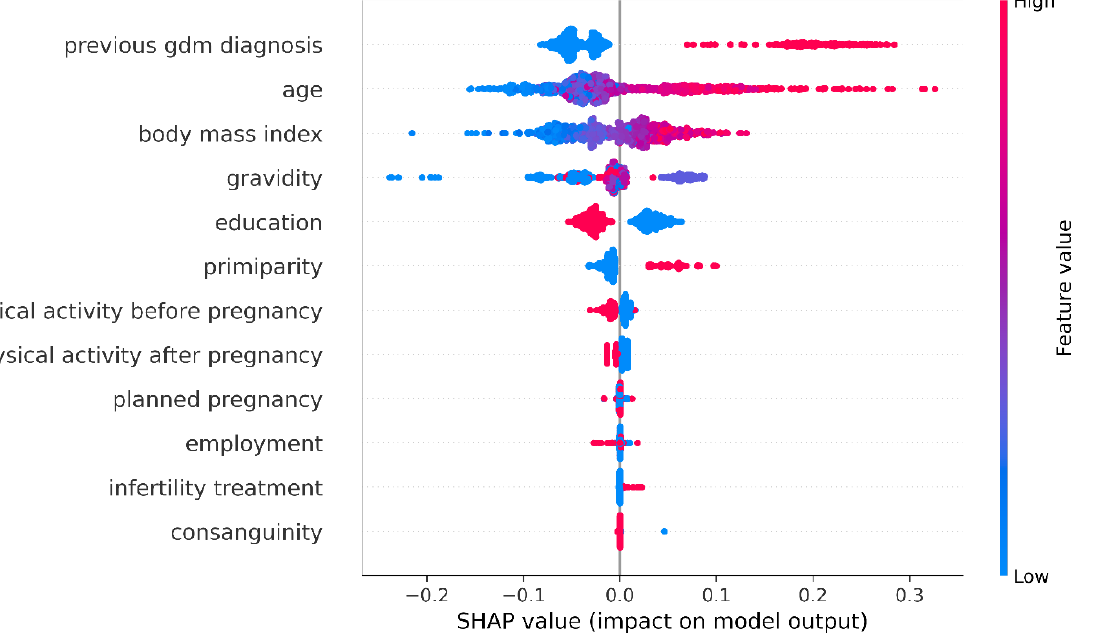
Figure 3. Summary plot to represent the impact of each feature on model performance.